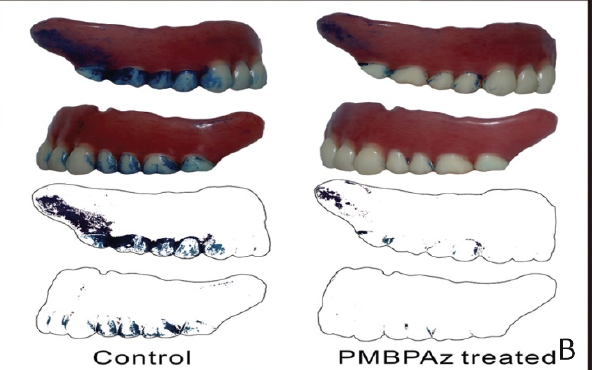
Figure 6. Plaque deposition on maxillary complete denture after 2 weeks. ( A ) Total denture area of polished surface after staining and digitization: left, control; right, PMBPAz treated; and plaque area of polished surface after selection without denture cleanser. ( B ) Total denture area of polished sur- face after staining and digitization: left, control; right, PMBPAz treated; and plaque area of polished surface after selection with denture cleanser [165]. Reproduced with permission from [165],